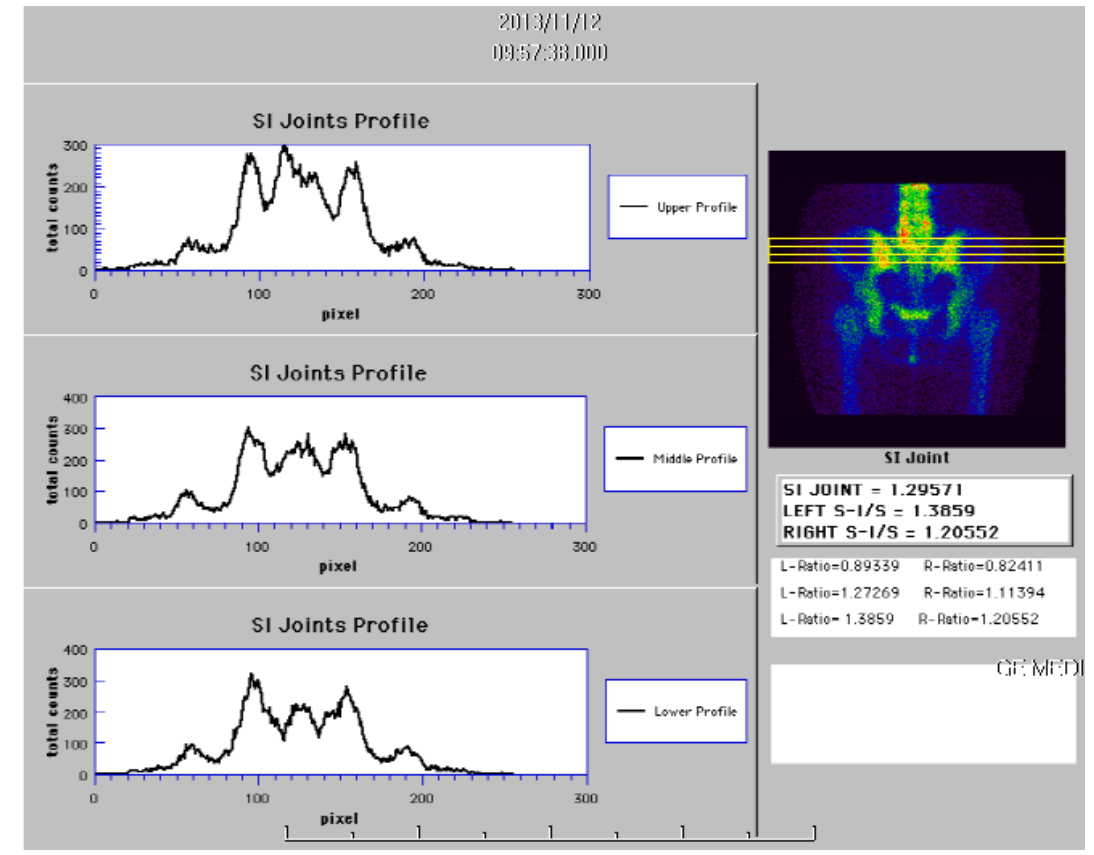
Figure 1: Representative images with sacroiliac joint disorder using quantitative sacroiliac scintigraphy in case 15 (Y.-T.G.) with undifferen- tiated spondyloarthritis. Measurement of the ratio between total number of counts from the right and left sacroiliac (SI) joints divided by sacrum (S) for each is calculated as SI/S ratio (right panel). The ratio for the upper, middle, and lower parts of both joints was measured separately, showing 0.89339, 1.27269, and 1.3859 in the left-sided joint (mean = 1.3859), and 0.82411, 1.11394, and 1.20552 (mean = 1.20552) in the right-sided joint. Table 2: Pearson’s correlation coefficient for ESR and SI/S ratio at Table 3: Pearson’s correlation coefficient for hs-CRP and SI/S ratio different parts. at different